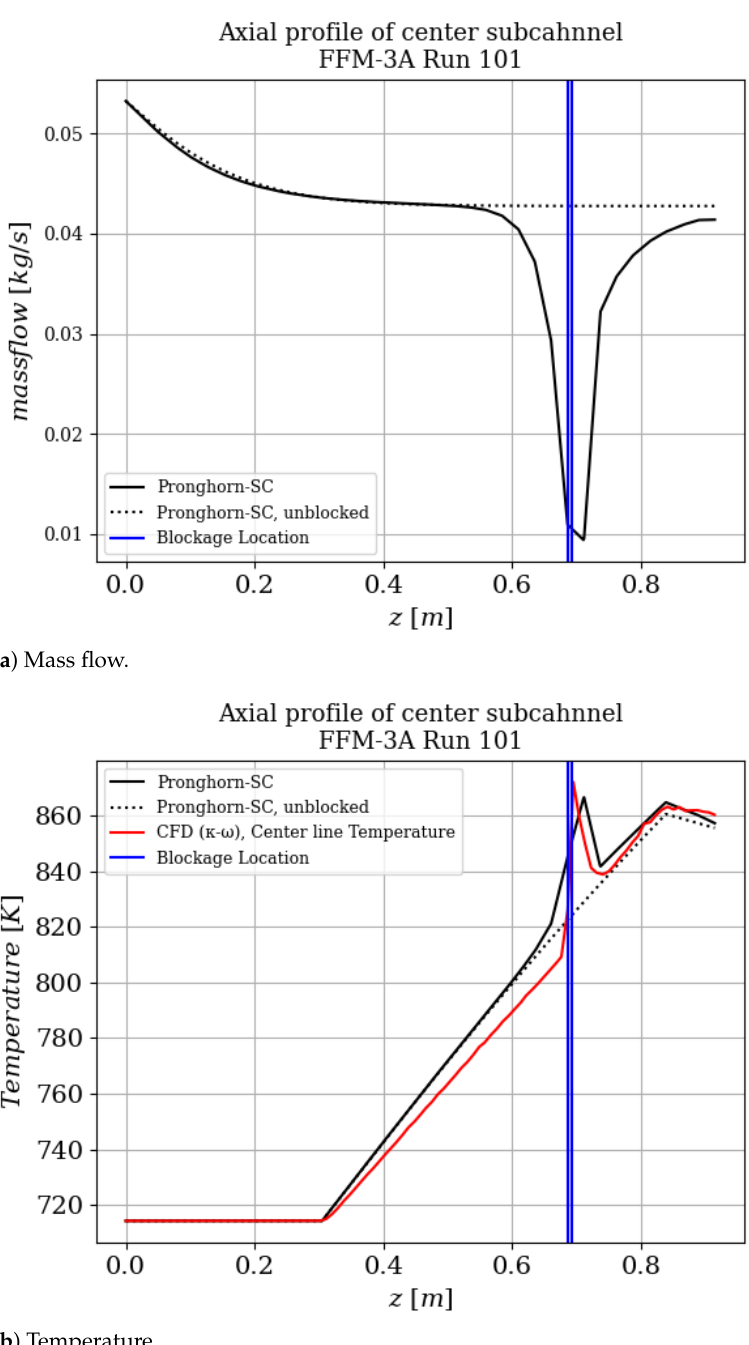
Figure 18. Axial profiles of center subchannel. ( a ) Mass flow. ( b )